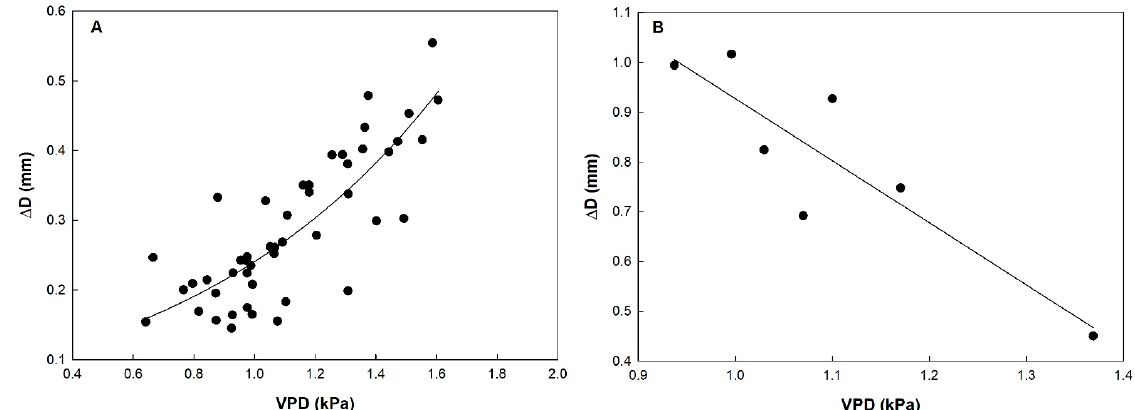
Figure 6 . Relationship between vapor pressure deficit (VPD) and daily fluctuations in fruit diameter ( Δ D) in ‘Keitt’ over the four monitoring periods ( A ), and ‘Tommy Atkins’ ( B ) mango at monitoring period I. Keitt: Δ D = 0.076 × e (1.1579VPD) ; R 2 = 0.679; p < 0.001. Tommy Atkins: Δ D = 2.175 − 1.248VPD; R 2 = 0.788; p = 0.008.